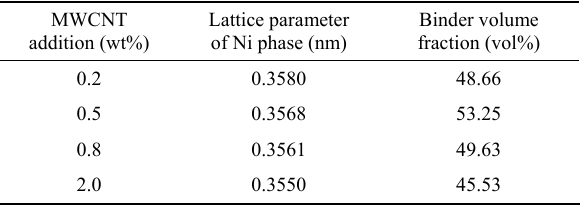
Table 4 Lattice parameters of Ni phase and binder volume fraction of the cermets MWCNT addition